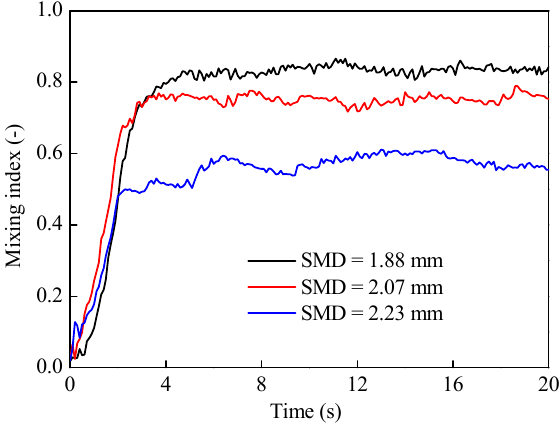
Figure 11. Time evolutionary profiles of mixing index with different SMD.